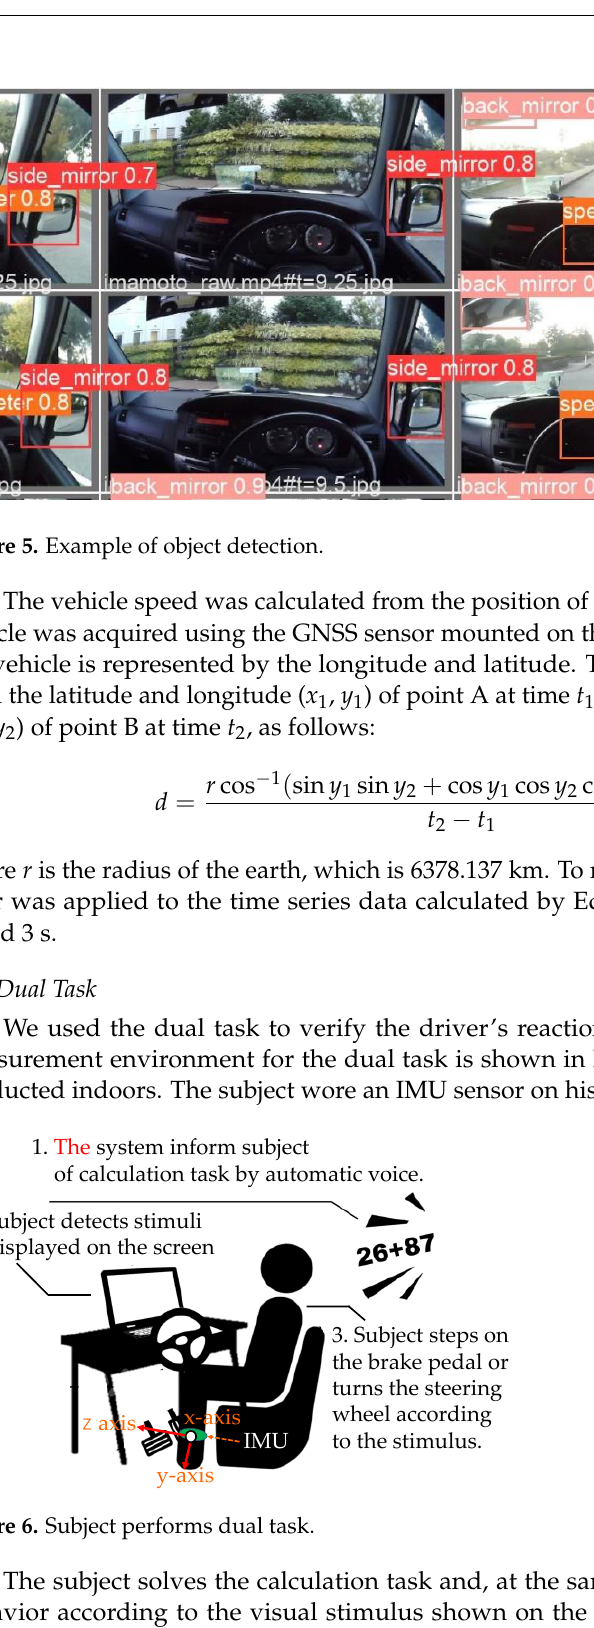
Figure 4. The result of object detection is shown by a PR curve(mAP@0.5).